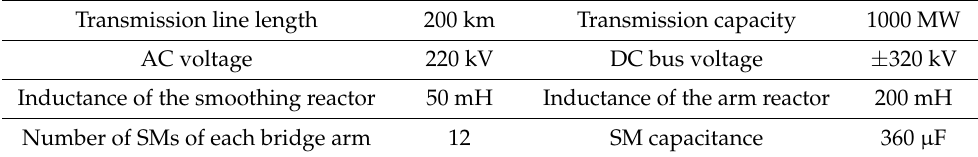
Table 1. The parameters of the system.